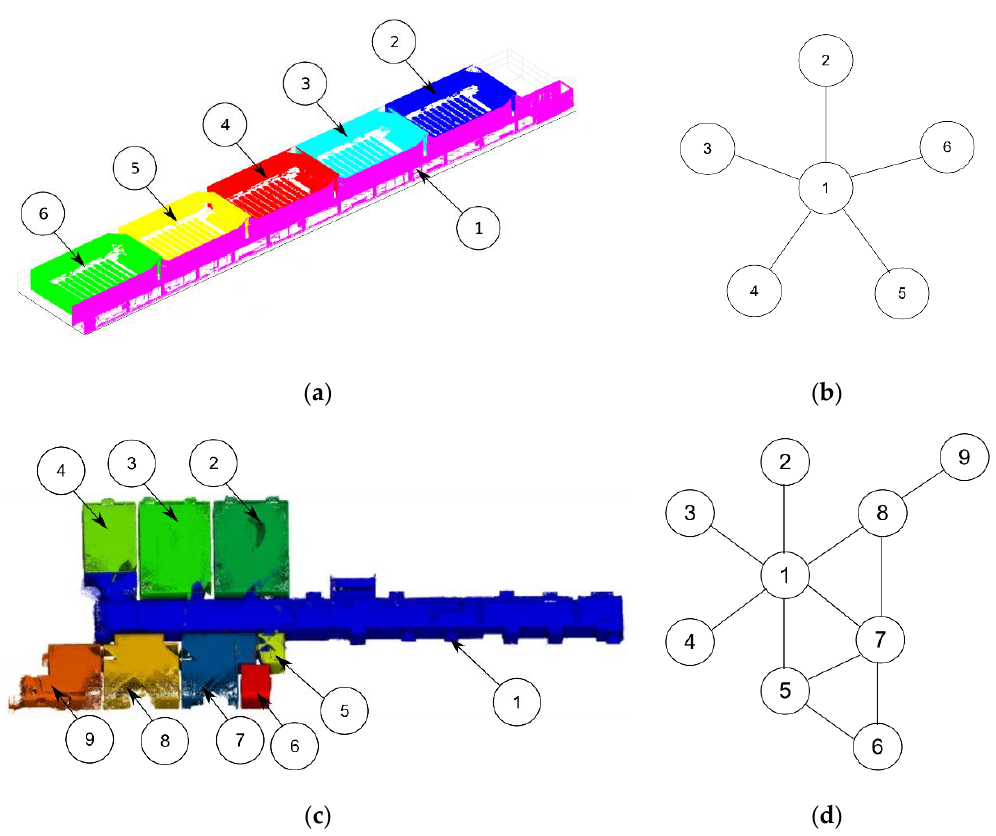
Figure 14. Navigation graph generation. ( a ) Numeration of rooms of the first example. ( b ) Navigation graph generated of the first example. ( c ) Numeration of rooms of the second example. ( d ) Navigation graph generated of the second example.